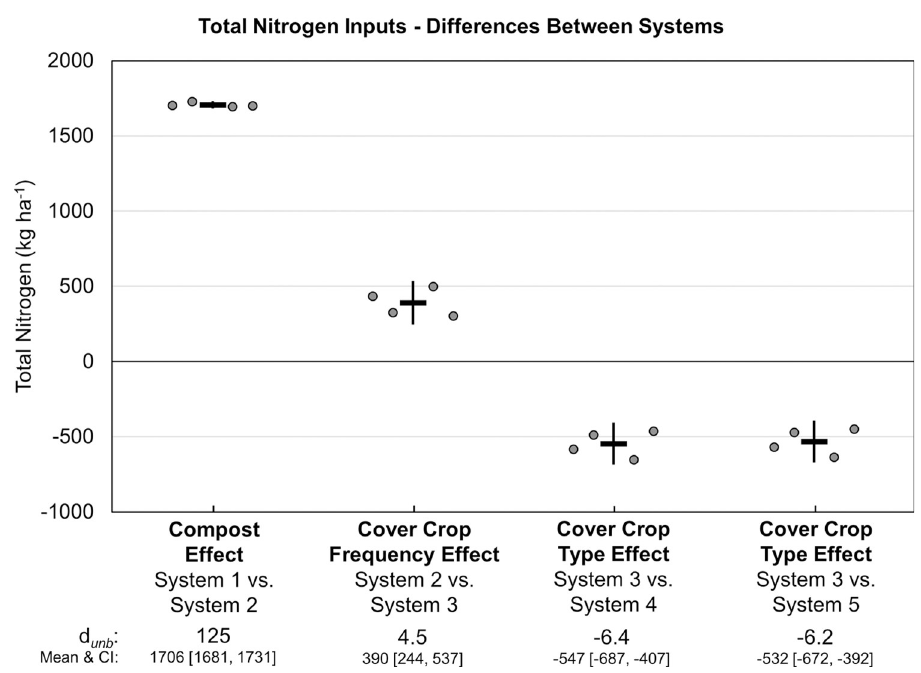
Fig 12. Mean paired difference in cumulative total nitrogen inputs between systems over eight years of vegetable production. Measurements were taken in five organic vegetable systems. Systems differed by annual compost additions, cover crop type and cover cropping frequency. System 1 = no compost+legume-rye 4 th year; System 2 = annual compost+legume-rye 4 th year; System 3 = annual compost+legume-rye annually; System 4 = annual compost+mustard annually; System 5 = annual compost+rye annually. The difference between Systems 4 and 5 is not presented because all inputs were fixed, thus there was no variation among replicates. Error bars are 95% confidence intervals (CI) around (horizontal line). Data points are replicates 1 through 4 averaged across years and are clustered around the mean left to right so as not to obscure the mean and CI. The standardized effect size (Cohen’s unbiased d , d unb ) is shown below the